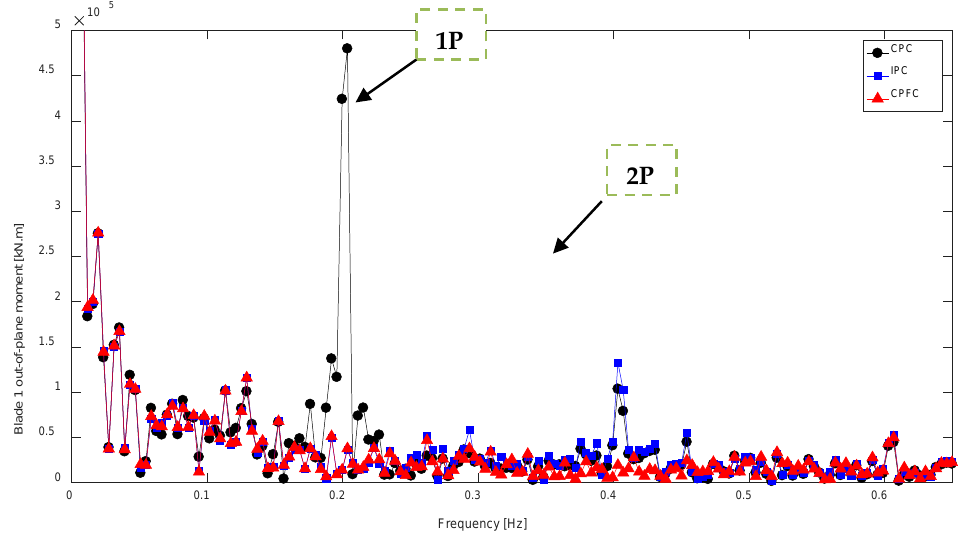
Figure 9. The PSD analysis of blade root out-of-plane bending moments.